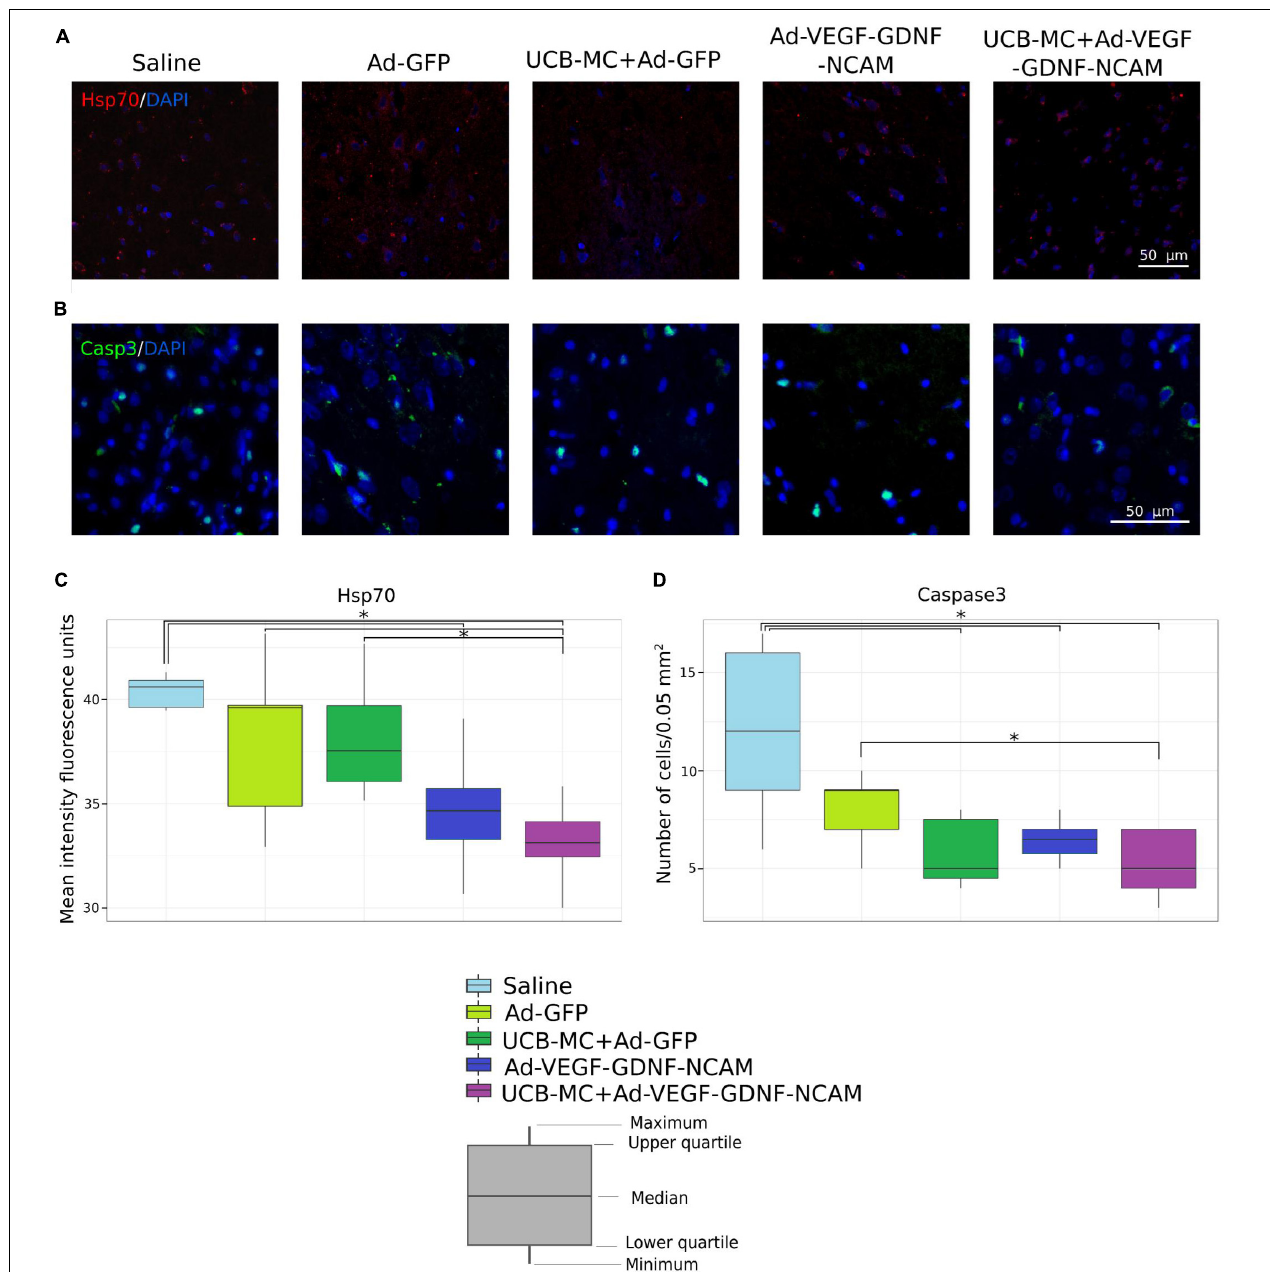
FIGURE 2 | Immunoexpression of Hsp70 and Caspase 3 in brain cortex 21 days after the distal permanent occlusion of the MCA. (A,B) Immunofluorescent staining with Abs against Hsp70 (A) and Caspase 3 (B) . Nuclei (blue) were counterstained with DAPI. Scale bar = 50 µ m. (C) Fluorescence density value of Hsp70 immunoexpression level. (D) Number of Caspase 3 immunopositive cells. Data are visualized using box plots. ∗ Difference between experimental groups, p < 0.05.